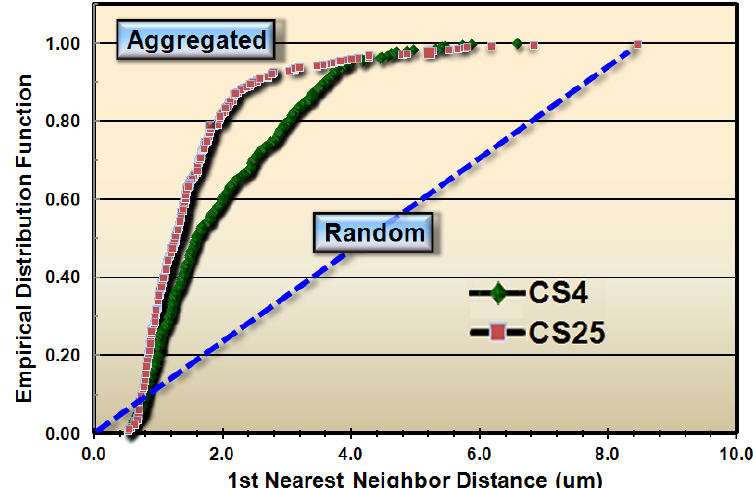
Figure 2. Cumulative empirical distribution function of the nearest neighbor distances between individual bacteria within images of biofilms CS4 (green diamonds) and CS25 (red squares). Differences in intensity of aggregated patterns are indicated by empirical distribution values that ascend above the diagonal dashed line of complete spatial